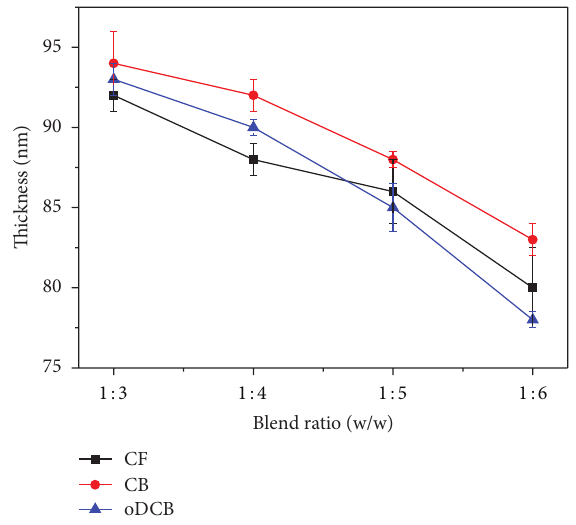
Figure 2: Thickness of PCDTBT: PC 71 BM active layer films with different composition prepared in solvents of chloroform (1wt%), chlorobenzene (2wt%), and o-dichlorobenzene